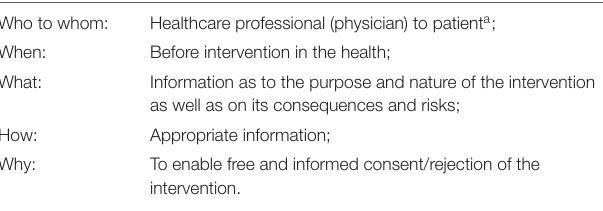
TABLE 1 | Summary of the requirement of the informed medical consent applicable to artificial intelligence (AI)’s external